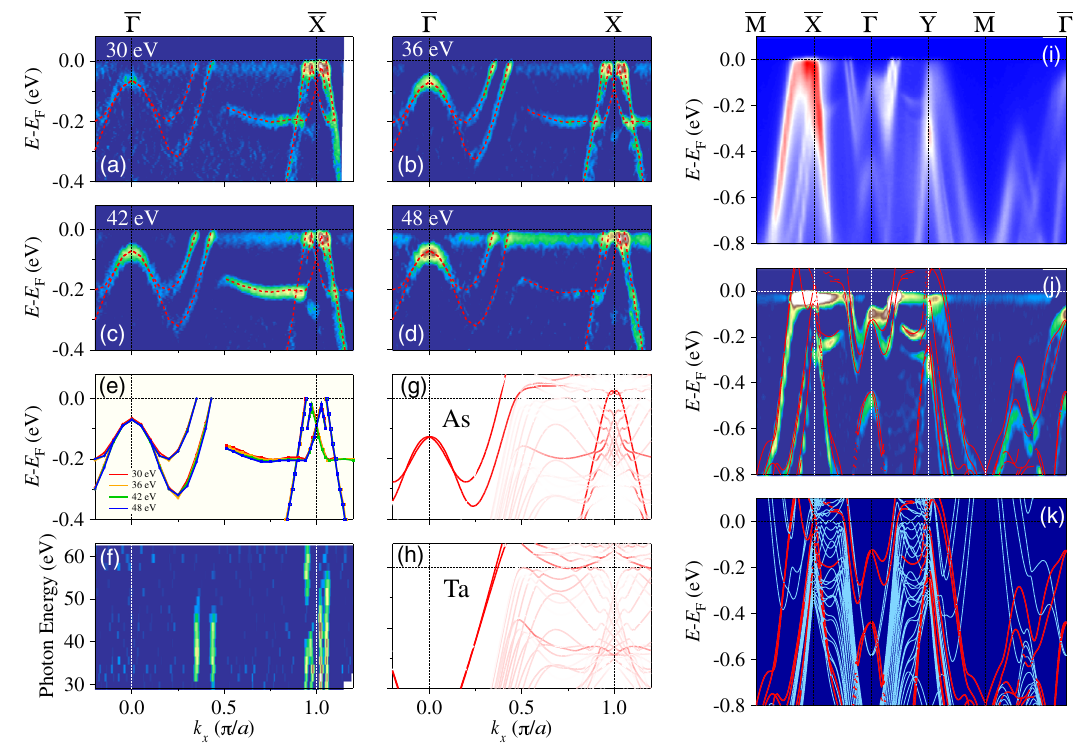
¯ Γ ¯ X - at h ν ¼ 30 , 36, 42, ¯ Γ ¯ Γ ¯ M ¯ X ¯ Y ¯ M - - - - - , respectively. For